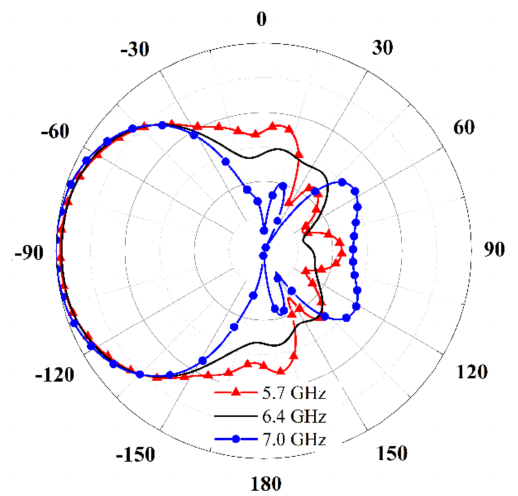
Figure 9. Normalized radiation patterns of the proposed antenna without metal plate in H-plane (YOZ